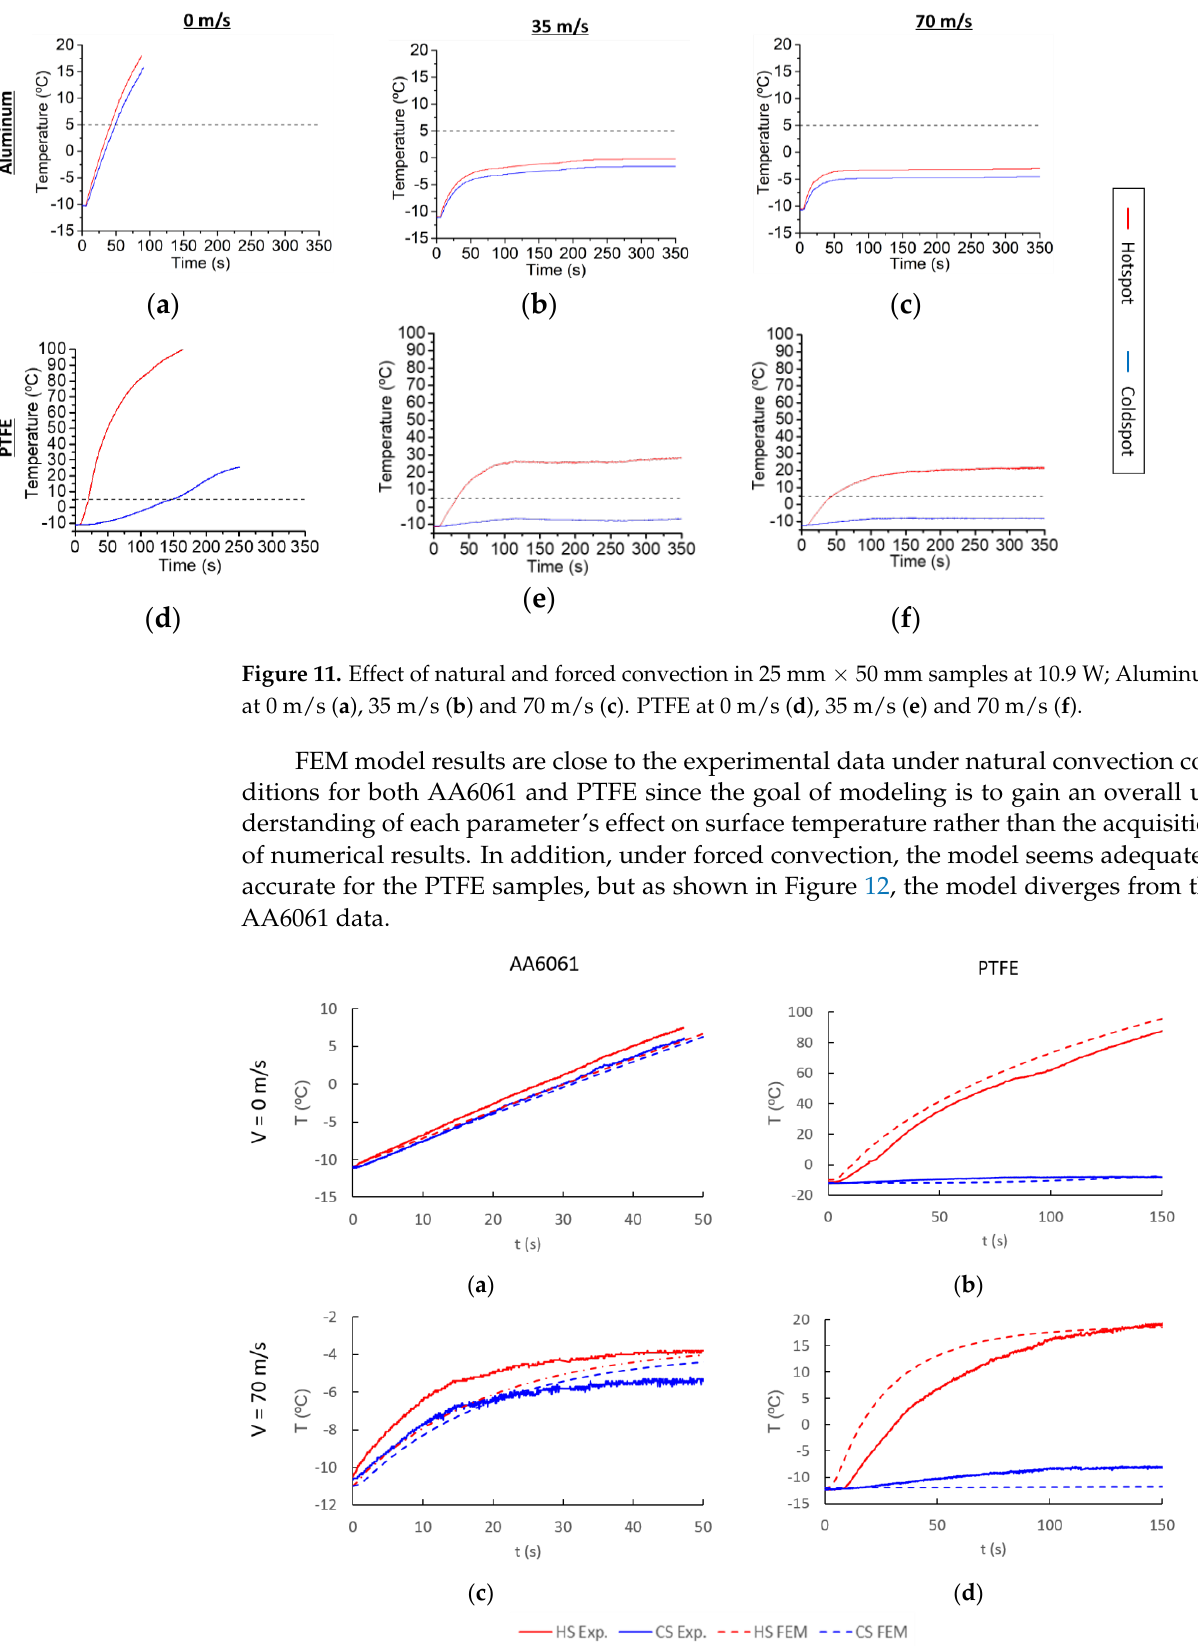
Figure 12. Experimental and modeling comparison of HS and CS at 0 m/s; ( a ) AA6061 and ( b ) PTFE and 70 m/s; ( c ) AA6061 and ( d ) PTFE as a function of heating time at 10.9 W.